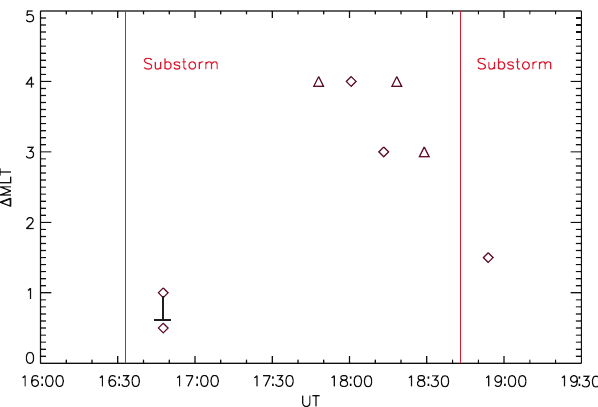
Figure 10. Time evolution of asymmetric conjugate auroral fea- tures. Diamonds are auroral asymmetries identified from Figs. 3 and 4 and listed in Table 1, while triangles are identified from images not shown, but which can be found in auxiliary material. The red vertical lines are the times of the